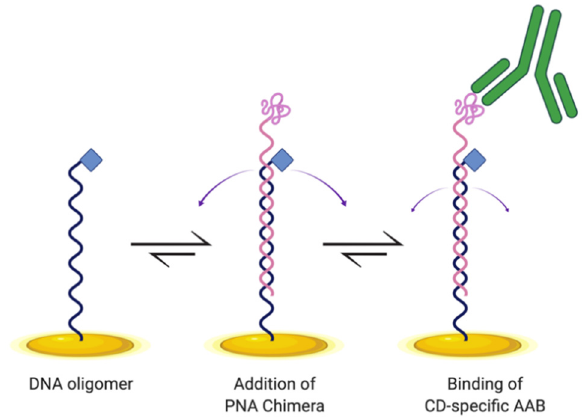
Figure 1. Schematic of E-DNA biosensor design for detecting celiac disease (CD) autoantibodies (AABs). DNA oligomer (black) is anchored to a gold electrode surface (gold) via a thiol–gold coordination bond, with methylene blue (blue diamond) functioning as a redox reporter. The DNA oligomer base-pairs to a peptide nucleic acid (PNA) chimera, which includes the gliadin-tTG synthetic neoepitope on the distal end (pink), and displays conformational flexibility (purple arrows) to enable electron transfer. Upon binding of the neoepitope by CD-specific AABs (green) present in a sample, the E-DNA biosensor is expected to undergo conformational change with reduced dynamics (smaller purple arrows), causing a reduction in peak current. Created with BioRender.com (accessed on 7 March